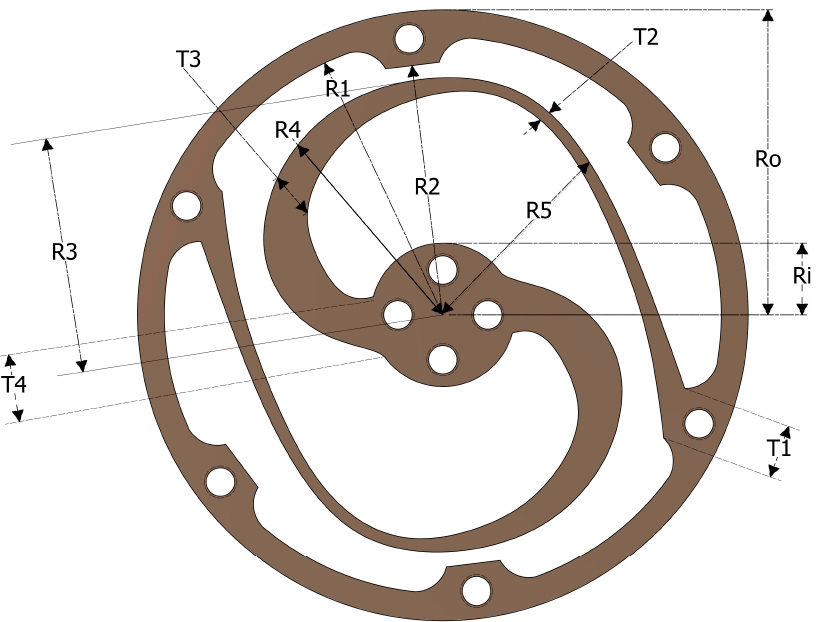
Figure 6. Morphology of the chosen topology.